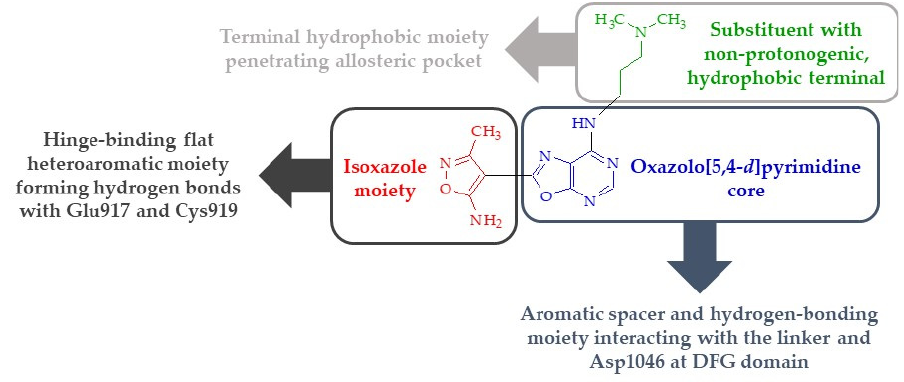
Figure 10. The main pharmacophoric features of newly designed VEGFR-2 inhibitors 3a–j , as exemplified by the most active compound 3g , developed on the basis of the theoretical study.